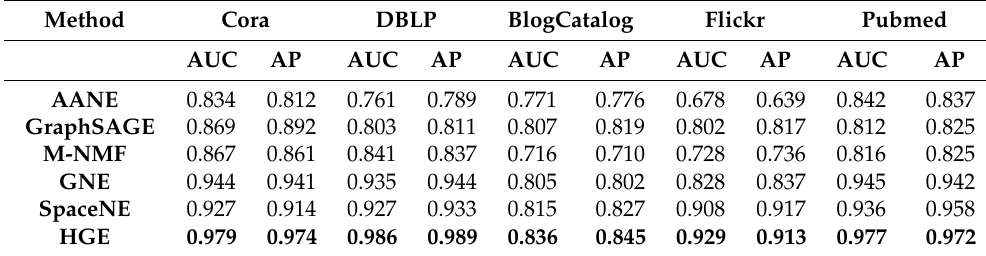
Table 4. Link prediction performance with embedding size L = 64.